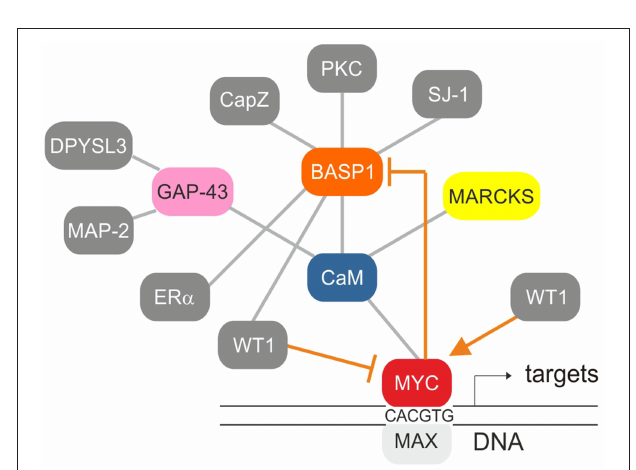
FIGURE 4 | Established protein-protein interactions (gray) and transcriptional regulation connections (orange) within the BASP1/CaM/MYC network. The MYC/MAX heterodimer binds to canonical motifs (E-boxes) present in the promoter regions of numerous MYC target genes. WT1 stimulates whereas WT1/BASP1 represses MYC transcription. MYC/MAX on the other hand represses BASP1 transcription thereby preventing its own repression by